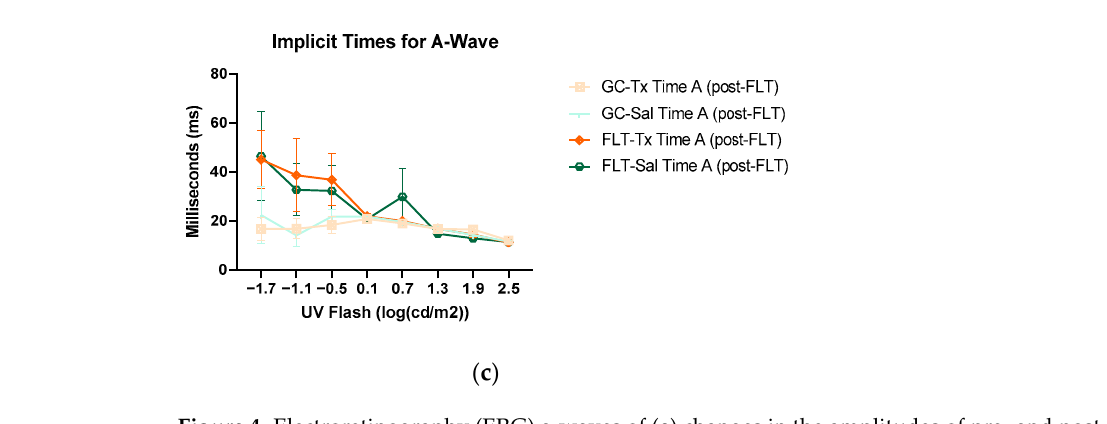
Figure 4. Electroretinography (ERG) a-waves of ( a ) changes in the amplitudes of pre- and post-flight (FLT) groups, and ( b ) changes in the amplitudes of pre- and post-flight ground control (GC) groups in response to increasing flash intensities. ( c ) Changes in the implicit time of post-flight FLT and GC groups. Each point represents the mean ± SEM (n = 8). Note that the response is lower with increased flash intensity in the post-flight group compared to the pre-flight response. The response is similar between pre- and post-flight measurements in the GC group.